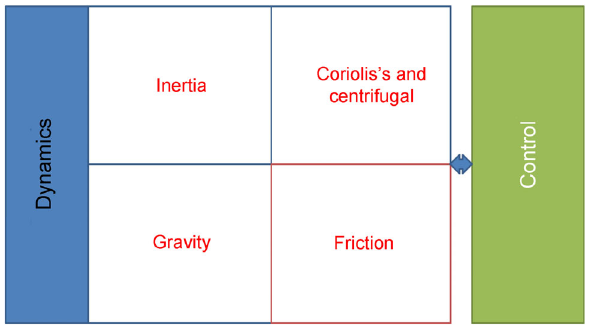
Fig. 5 Representation of the dynamics equation and its components.